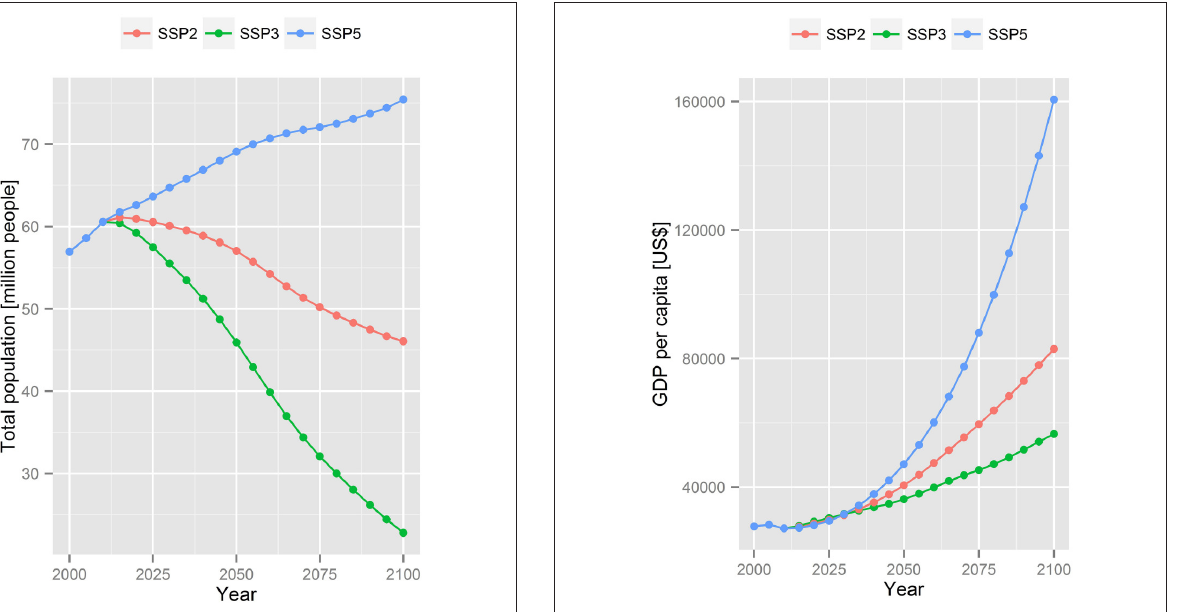
FIGURE 3 | Total population of Italy for each storyline used in this study. FIGURE 4 | GDP per capita in Italy for each storyline used in this